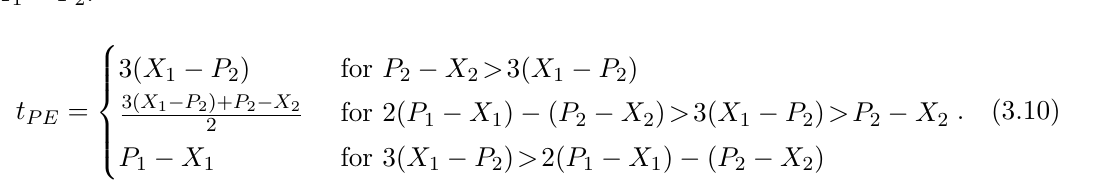
Figure 3: A cartoon of the trajectory of the operator. Orange dashed and dotted arrows illustrate the trajectory in t 2 of the operators, while the purple dashed and dotted arrows illustrate that the trajectory in t 1 . In the limits where t 1 or t 2 , operators ! 1 ! 1 approach 0 or ⇡ .